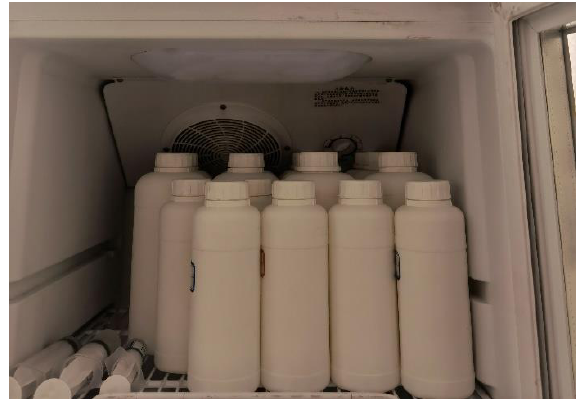
Figure 7. Storage of seawater samples.